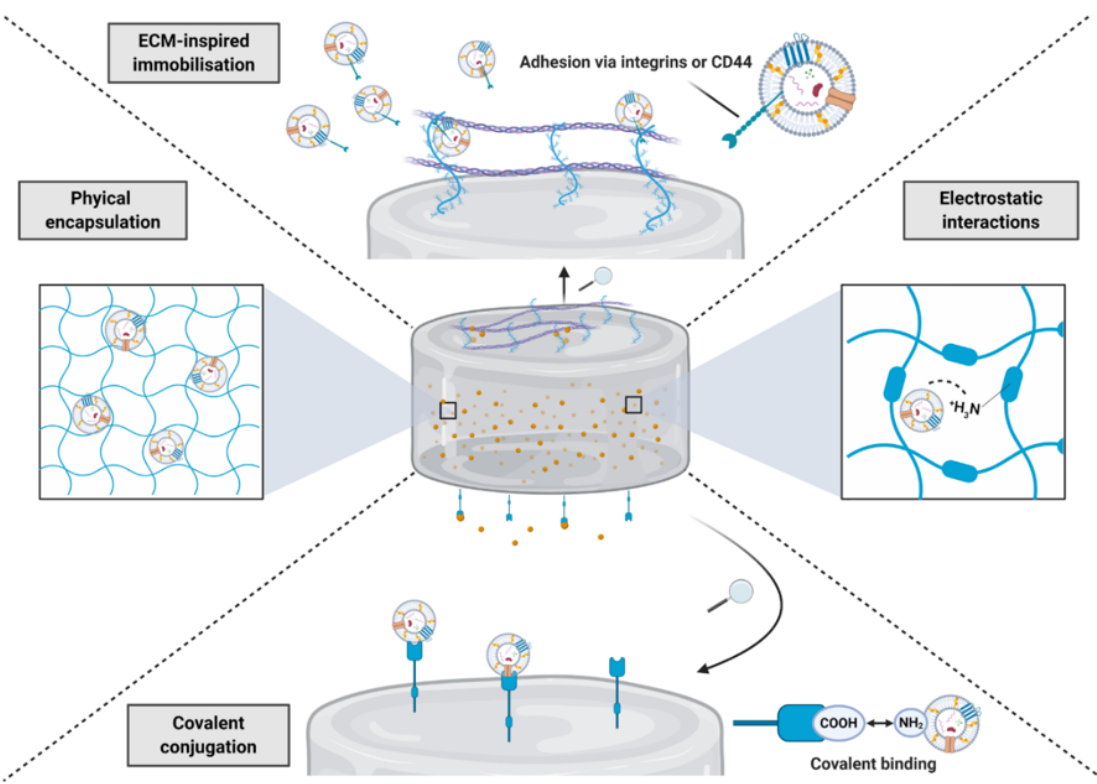
Figure 7. Strategies to immobilise EVs within biomaterials. Methods of EVs incorporation within biomaterials include physical entrapment, extracellular matrix (ECM)-immobilisation, electrostatic interactions and covalent conjugation.